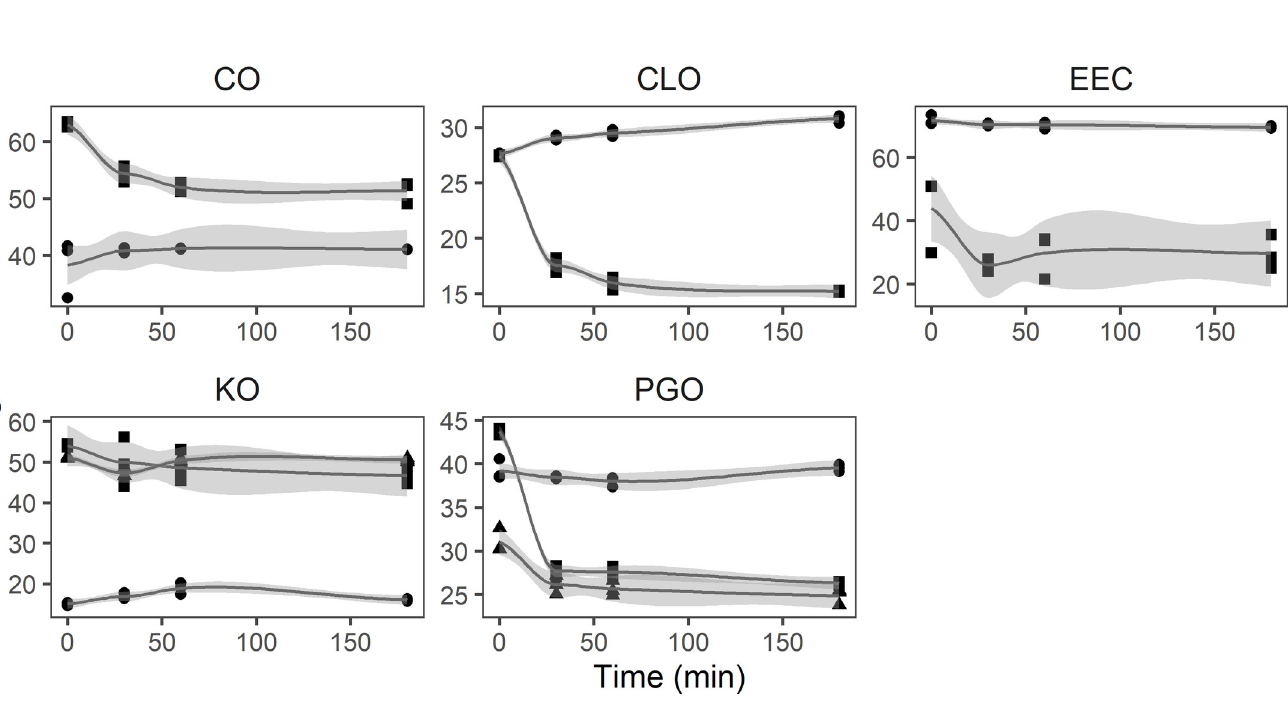
PLOS ONE | https://doi.org/10.1371/journal.pone.0252125 June 9, 2021 11 /